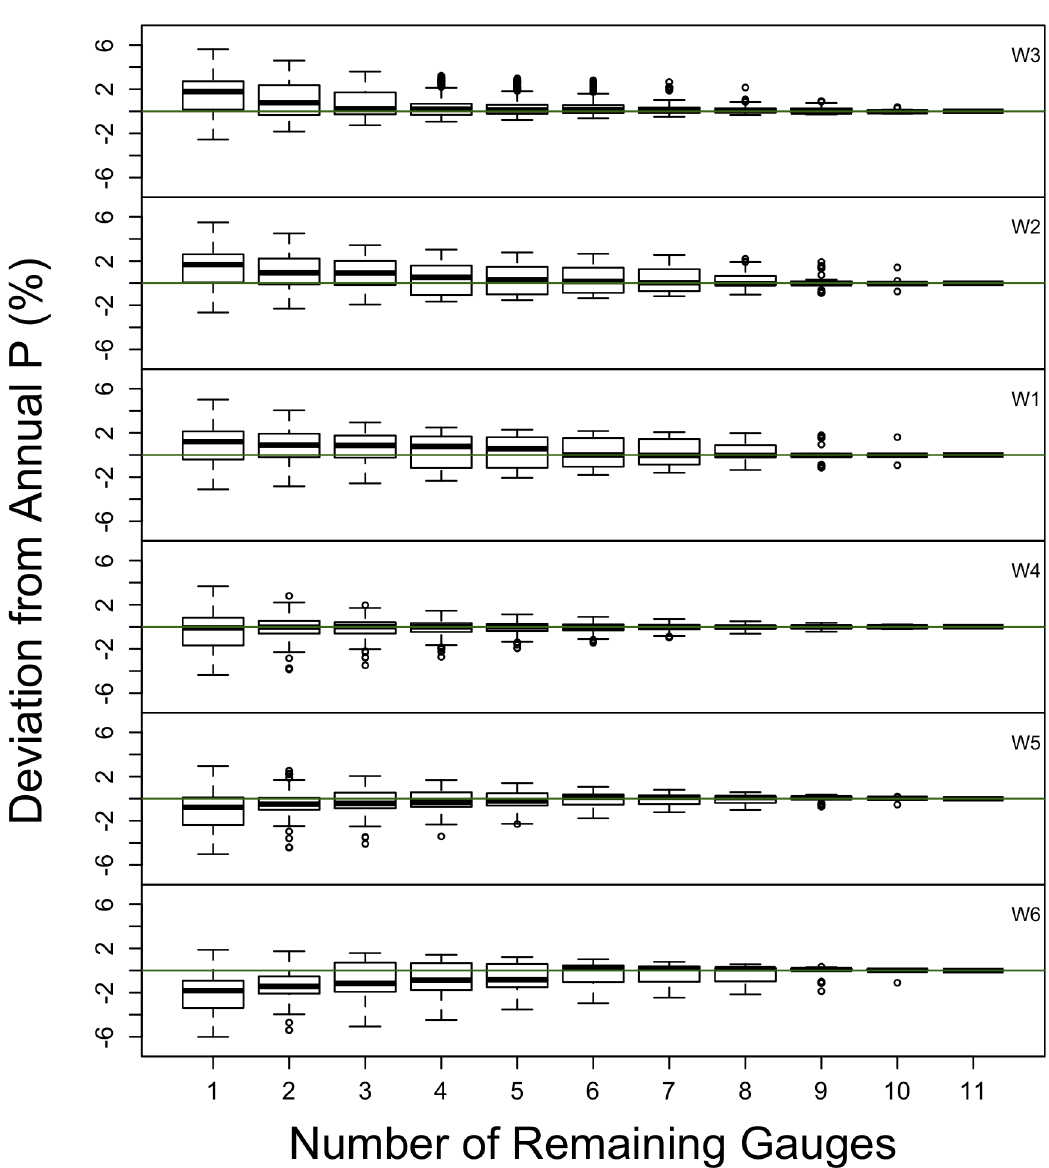
Fig 3. The effect of removing gauges for each of the six south-facing catchments is shown as the absolute value of the deviation of annual precipitation estimates for all possible combination of gauges. The results are shown as a function of the number of gauges remaining. The deviation from annual precipitation is based on the IDW method. The green line indicates zero